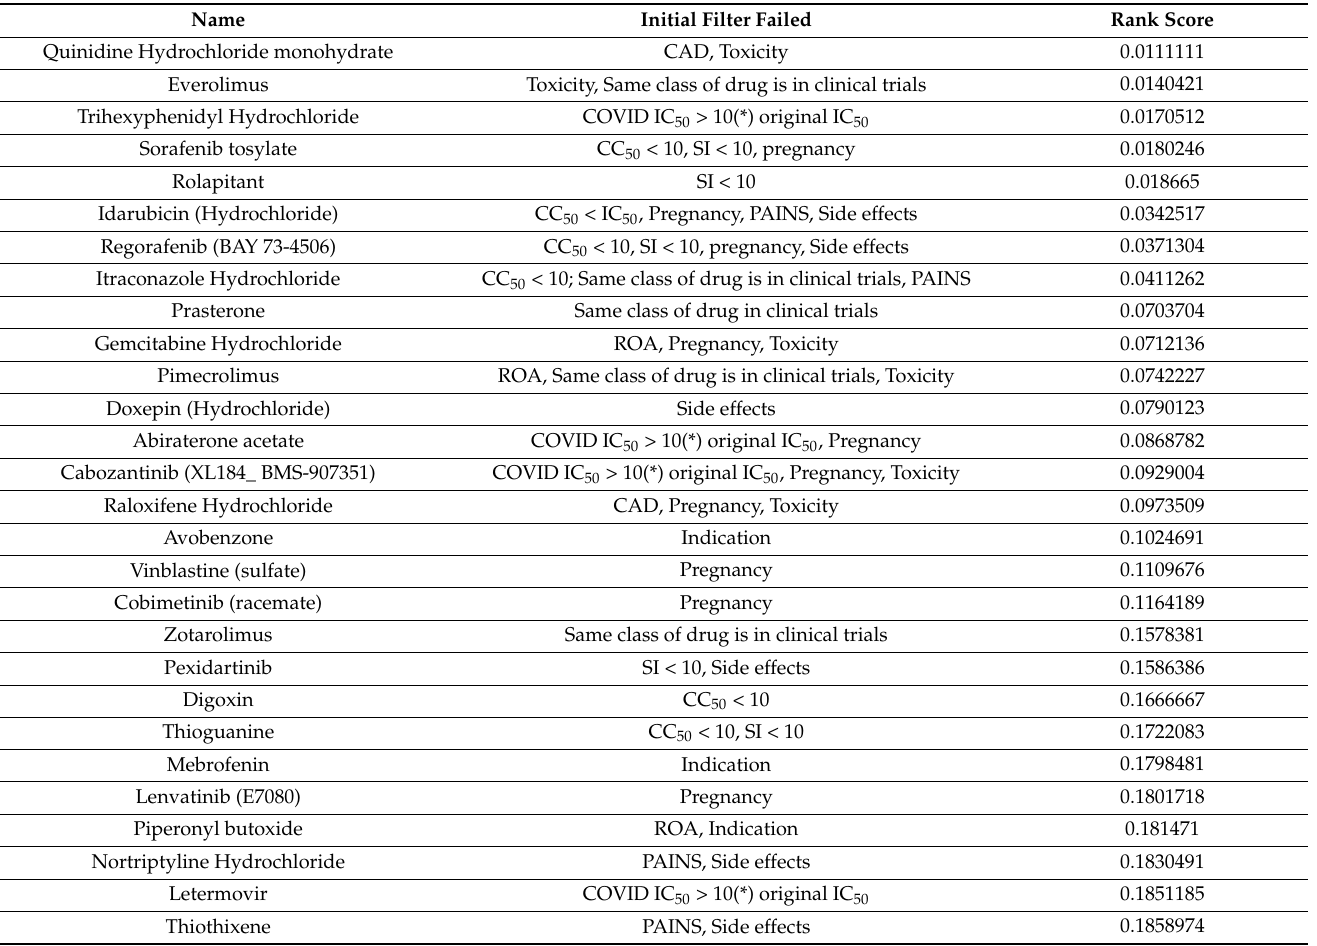
Table 3. Drugs with an activity rank score < 0.2 that were reconsidered for repurposing against COVID-19 despite not passing the filter